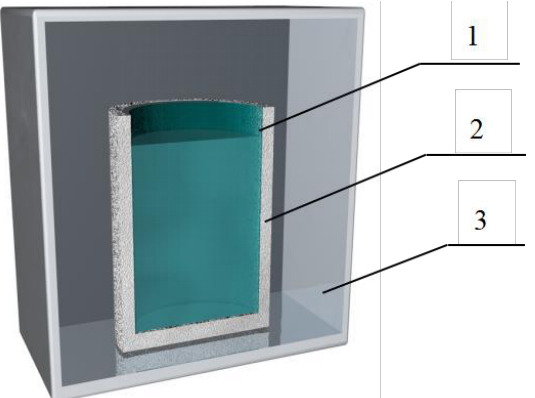
Figure 2. Schematic diagram of the ice simulation experiment device. 1 — High borosilicate glass reactor; 2 — EPS insulation layer; 3 — Low temperature test chamber.